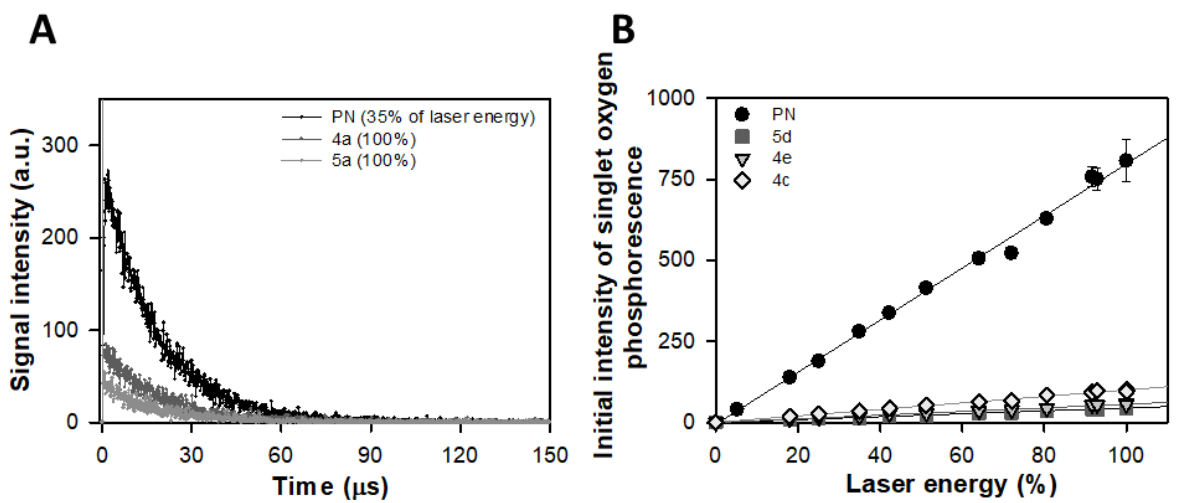
Figure 1. ( A ) Time-resolved singlet oxygen ( 1 O 2 , 1 Δ g ) phosphorescence at 1270 nm detected in DMSO: ethanol solutions (1:1, v / v ) of perinaphtenone (PN) and selected samples ( 4a and 5a ) upon excitation with 420 nm laser pulses at 35% and 100% of laser energy, respectively. ( B ) Dependence of the initial intensity of 1 O 2 ( 1 Δ g ) phosphorescence generated by PN and selected samples on relative excitation energy.